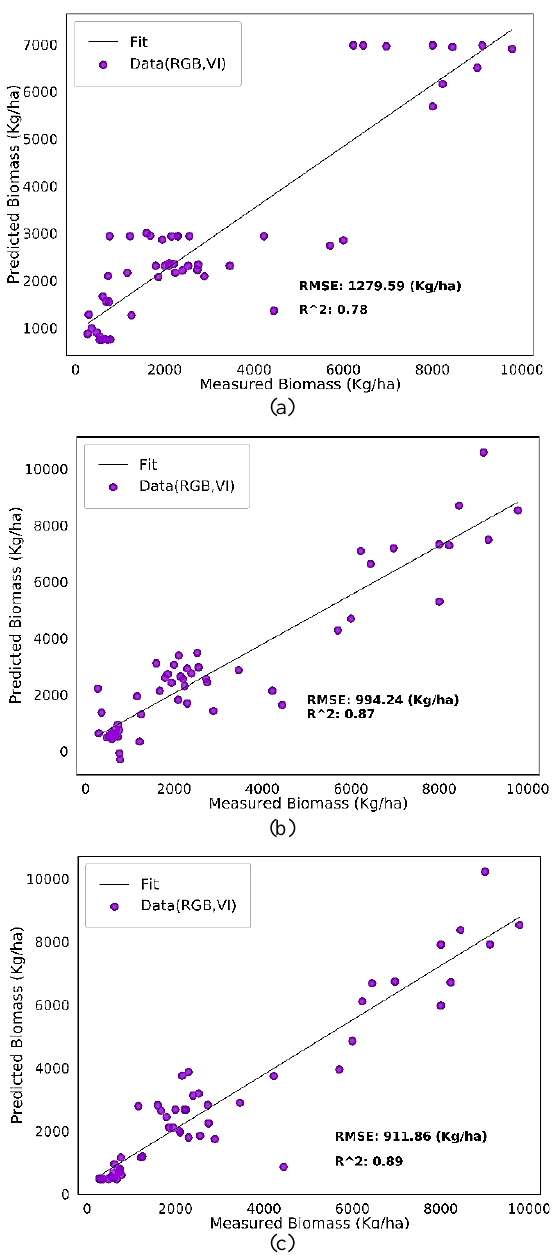
Figure 6. Scatterplots of wheat biomass estimates with three ELAs: (a) Random Forest, (b) Gradient Boosting Machine, and (c) eXtreme Gradient